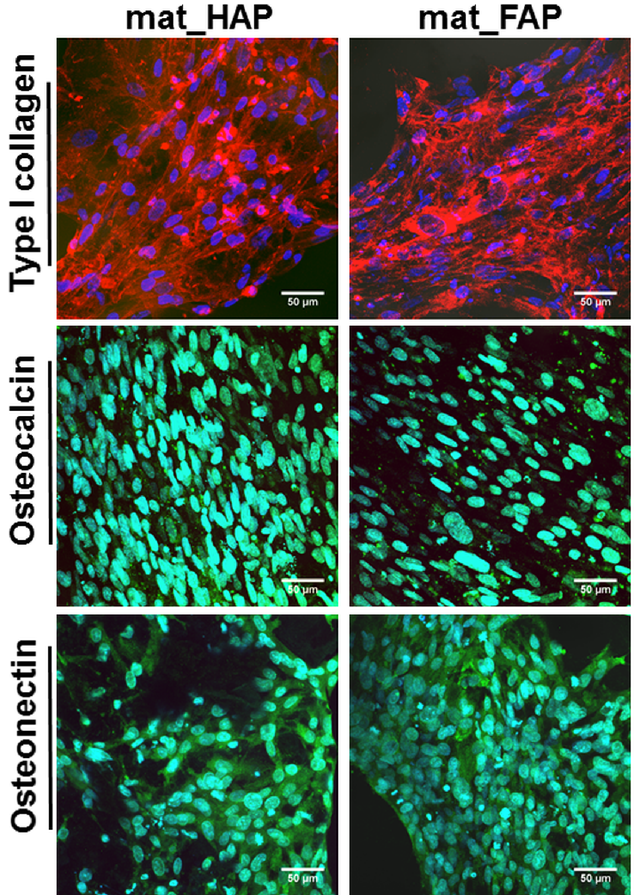
Figure 6. Confocal laser scanning microscope images presenting immunofluorescent staining of type I collagen (red fluorescence), osteocalcin (green fluorescence), and osteonectin (green fluorescence) in the extracellular matrix of human foetal osteoblasts (hFOB 1.19), grown on the biomaterials for 21 days (blue fluorescence—nuclei, magnification 400 × ; scale bar = 50 µm).